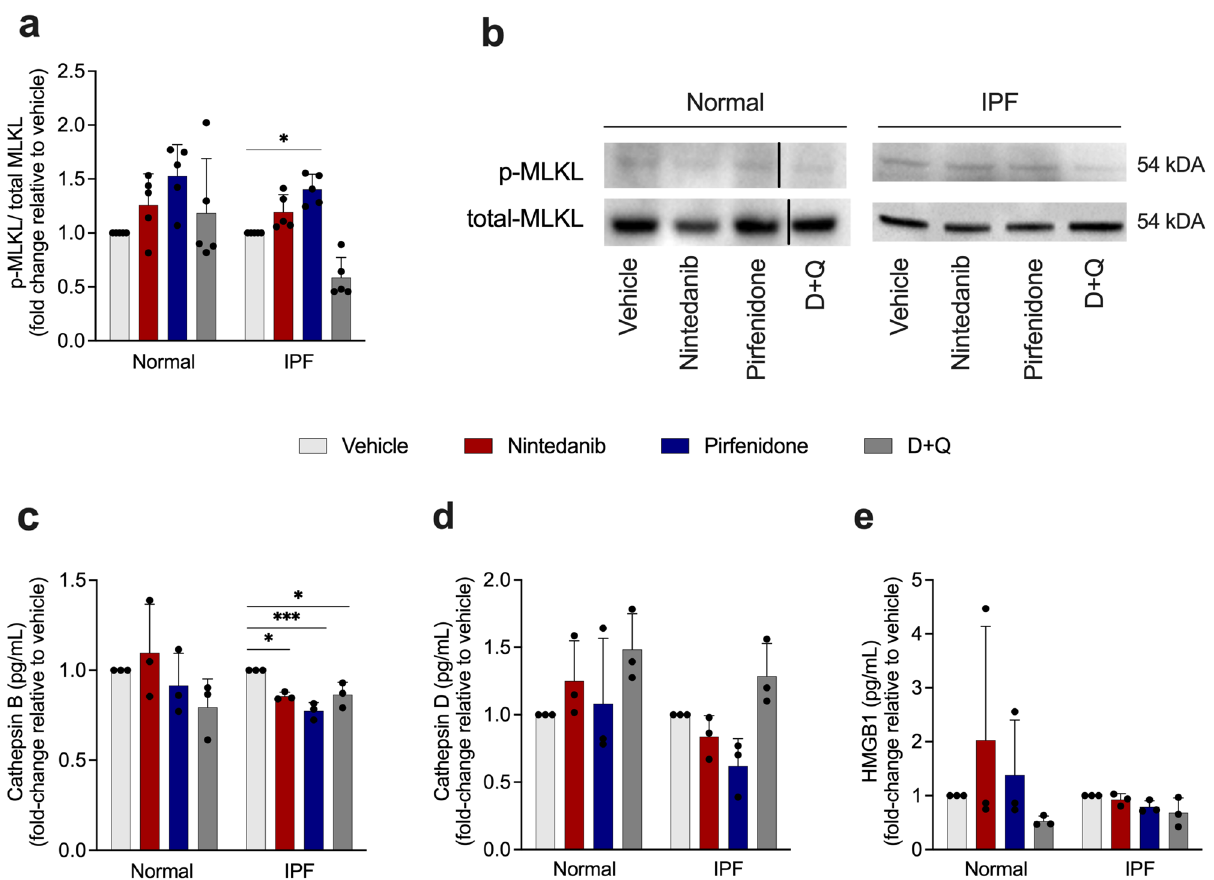
Figure 7. Pirfenidone enhances MLKL phosphorylation and reduces cathepsin B release. Western blot quantification of MLKL phosphorylated/MLKL total of normal and IPF senescent lung fibroblasts treated for 24 h with nintedanib (300 nM), pirfenidone (2.5 mM), D + Q (20 μM/15 μM) or control (vehicle; DMSO 0.05%) ( a ). Representative western blot of p-MLKL/MLKL protein expression ( b ). Cathepsin B ( c ), cathepsin D ( d ) and HMGB1 ( e ) levels in senescent fibroblasts supernatant after treatment with nintedanib (300 nM), pirfenidone (2.5 mM), D + Q (20 μM/15 μM) or control (vehicle; DMSO 0.05%) for 24 h. Data are presented as mean ± SD (n = 3 or 5 per group). p values were calculated using one-way ANOVA followed by Tukey’s test. *p < 0.05 **p < 0.01 and ***p < 0.001 as indicated by the